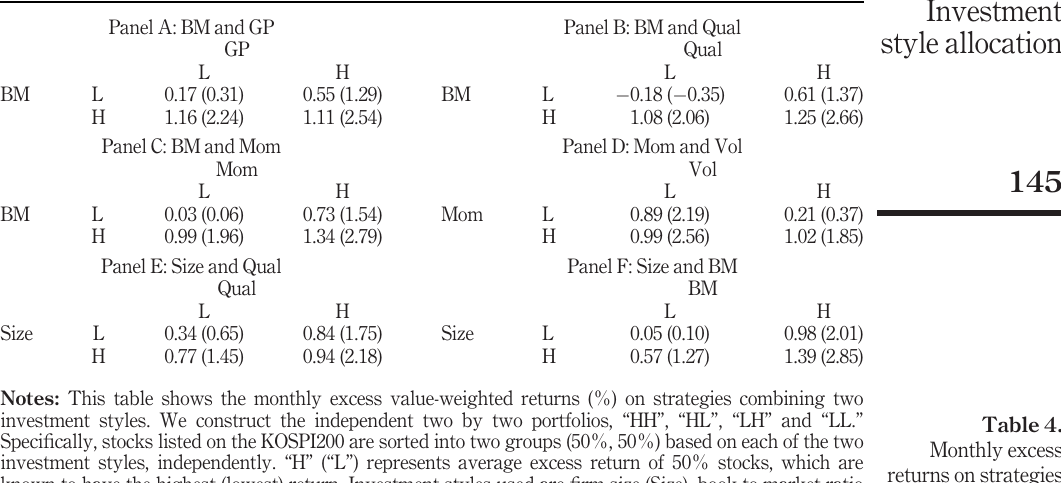
returns on strategies combining two investment